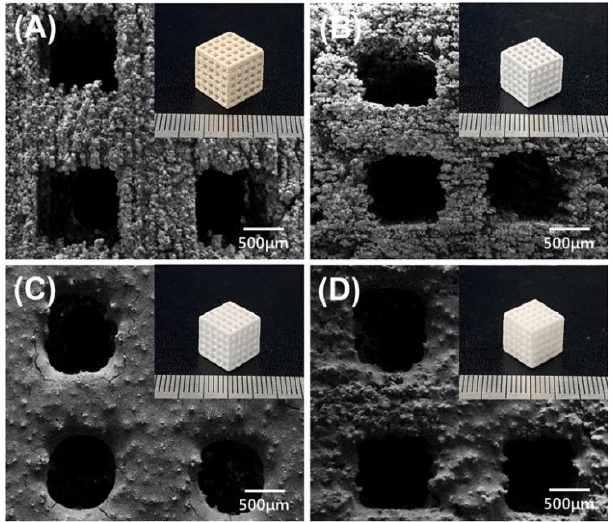
Figure 14. FE-SEM and (inset) optical images of the surface of the 3D-printed ( A ) CSH, ( B ) BCP, ( C ) BCP/ D -PCL, and ( D ) BCP/ m -PCL scaffolds [82].